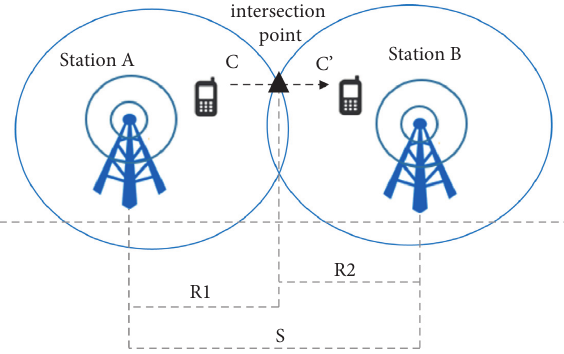
Figure 5: Movement of passengers after leaving the